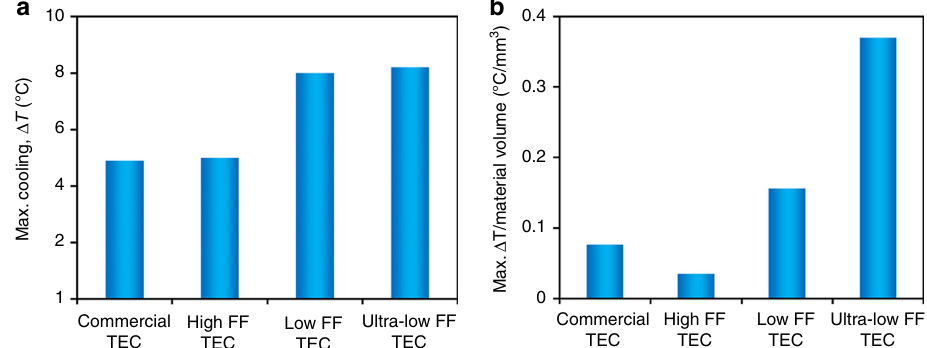
Fig. 9 Performance comparison among commercial and fabricated TECs. a Maximum cooling (temperature drop from initial temperature). The ultra-low FF TEC provides 1.7 times higher cooling than the commercial TEC. b Maximum cooling over volume of TE materials. The cooling over material volume for the ultra-low FF TEC is fi ve times higher than that of the commercial